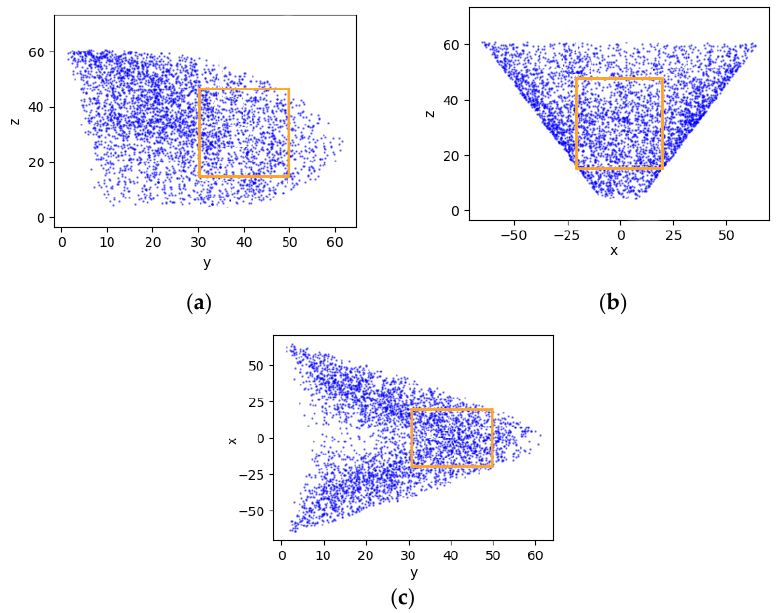
Figure 13. Operational space of the manipulator ； ( a ) View along the x-axis; ( b ) View along the y-axis; ( c ) View along the z-axis.